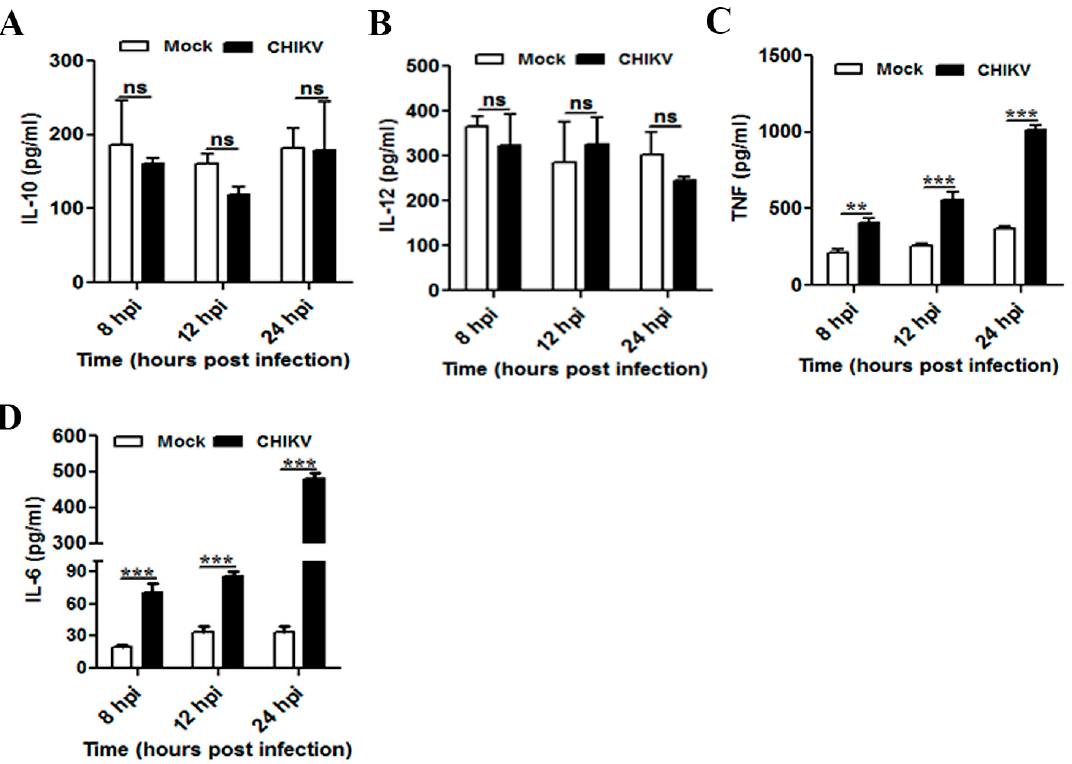
Figure 3. Modulation of macrophage derived cytokines during CHIKV infection. Raw264.7 cells were infected with CHIKV at MOI 5. The cell culture supernatants were collected at different time points and the levels of secreted cytokines in the samples were quantified. Graphical representation showing the amount of secreted: IL ‐ 10 ( A ); IL ‐ 12 ( B ); TNF ( C ); and IL ‐ 6 ( D ) in mock and CHIKV infected macrophage as quantified using sandwich ELISA. Data represent mean ± SEM of at least three independent experiments. p < 0.05 was considered as statistically significant difference between the groups. (ns, non ‐ significant; ** p ≤ 0.01; *** p ≤ 0.001).